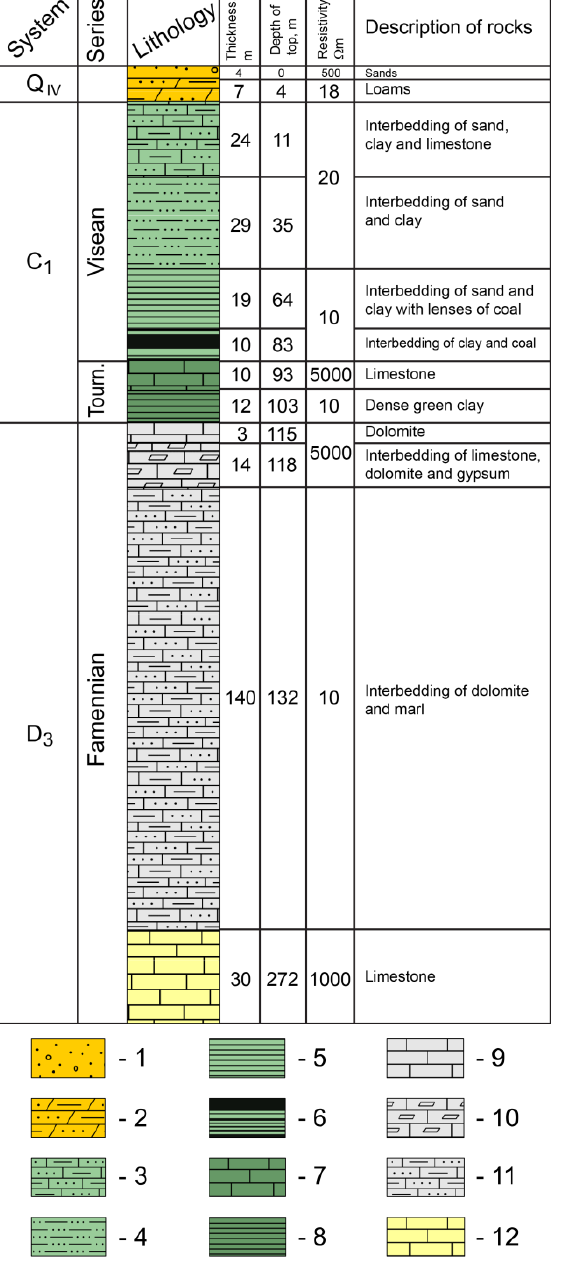
Figure 8. The lithologic column from the borehole shown in Figure 1. Lithology explanation: 1—Sands (Q IV ), 2—loams (Q IV ), 3—Interbedding of sand, clay and limestone (C 1 ), 4—Interbedding of sand and clay (C 1 ), 5—Interbedding of sand and clay with lenses of coal (C 1 ), 6—Interbedding of clay and coal (C 1 ), 7—Limestone (C 1 ), 8—Dense green clay(C 1 ), 9—dolomite (D 3 ), 10—Interbedding of limestone, dolomite and gypsum (D 3 ), 11—Interbedding of dolomite and marl (D 3 ), 12—Limestone (D 3